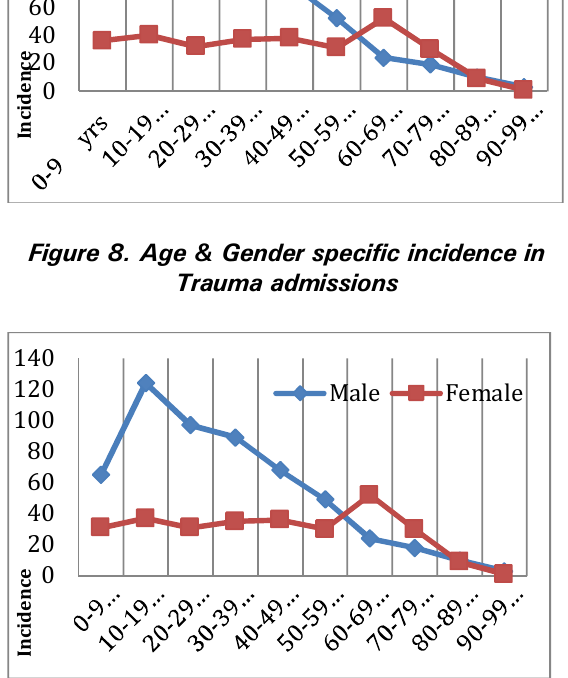
Figure 9. Age & Gender specific incidence in Fracture admissions